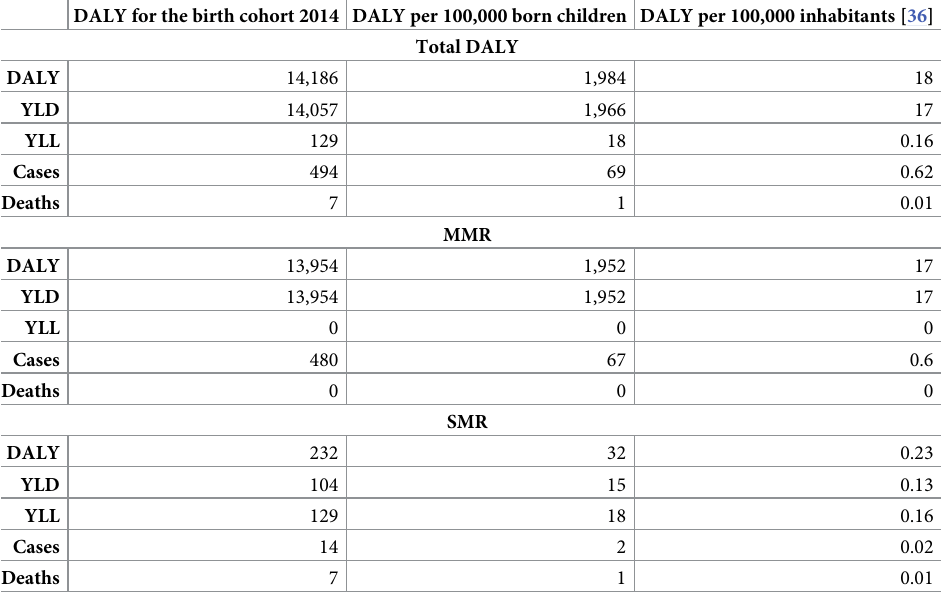
Table 2. Disease burden of methylmercury for 2014 born children, per 100,000 born children and